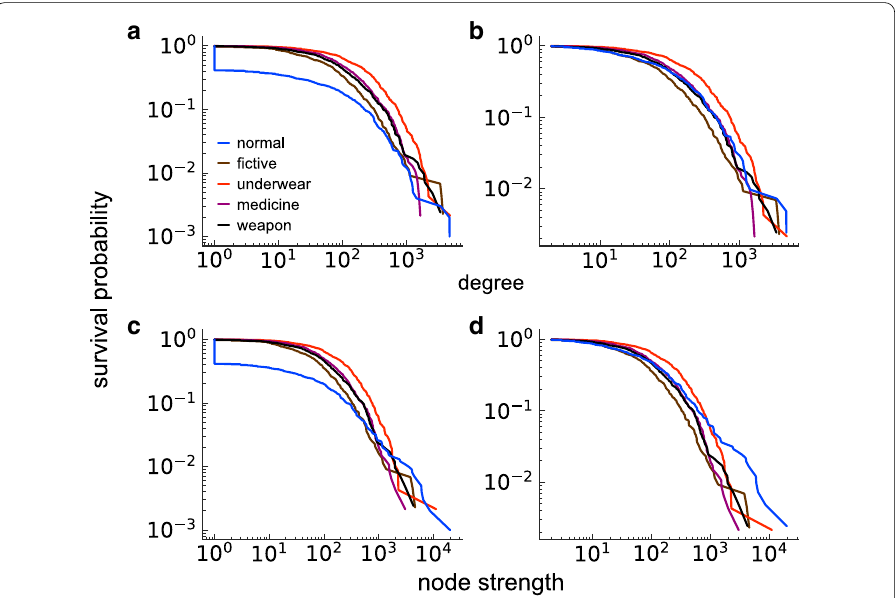
Fig. 3 Survival probability of the degree for each user type. a Degree (i.e., k i ) for all nodes. b Degree for the nodes with k i ≥ 2 . c Strength (i.e., s i ) for all nodes. d Strength for the nodes with s i ≥